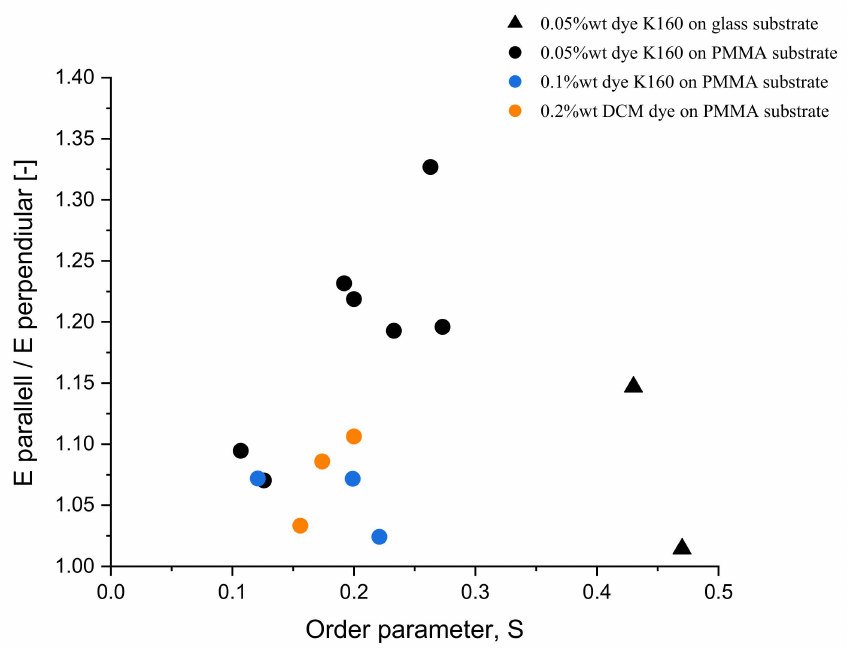
Figure 4. Emission ratio of parallel to perpendicular edges for K160 (0.05 wt% black, 0.1 wt% blue) and DCM (orange) samples on both glass (triangles) and PMMA (circles) substrates as a function of the order parameter, S